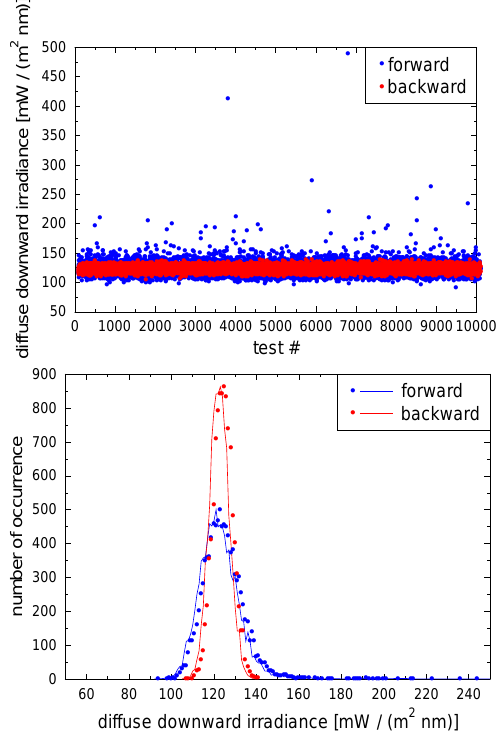
Fig. 3. (Top) Domain average diffuse downward horizontal irra- diance calculated in forward and backward mode; for each of the 10000 data points, 1000 photons were traced. (Bottom) Histogram of the diffuse irradiances shown in the top plot.